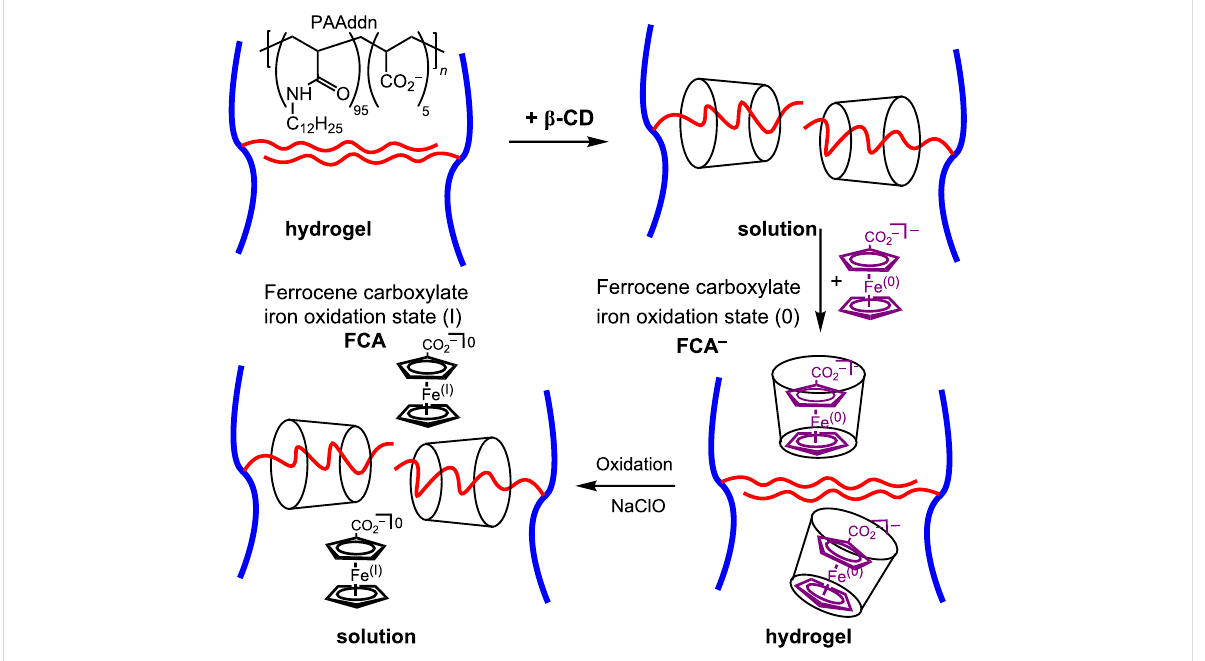
Figure 20: Solution to hydrogel transitions for two segments of PAAddn in the presence of β -CD and change in the ferrocenecarboxylate oxidation state in basic aqueous solution